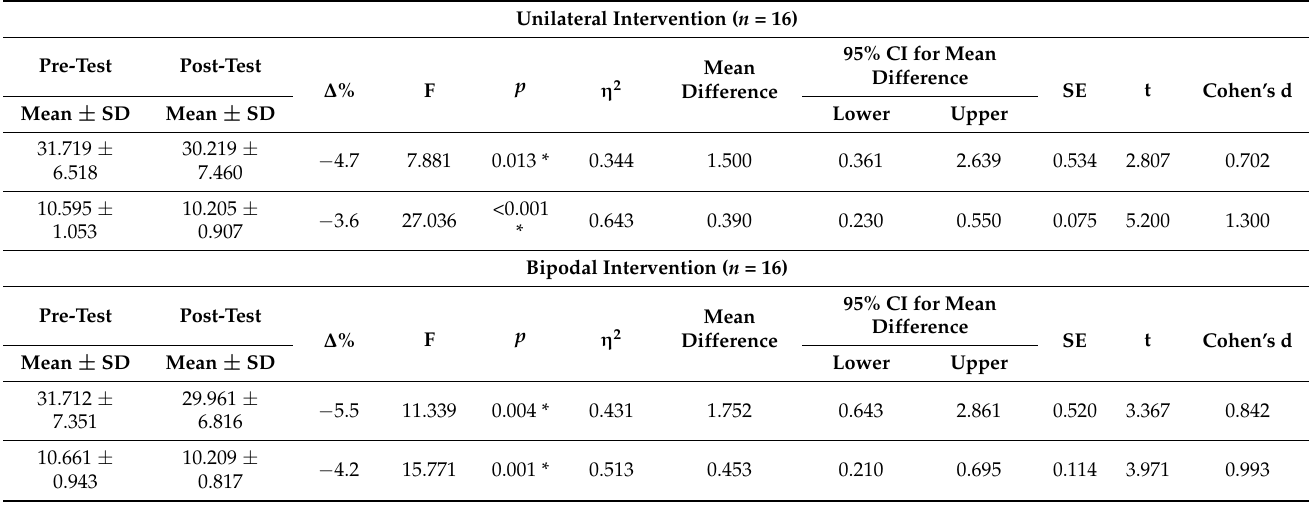
Table 1. Comparison between the pre-test and the post-test of the PAPE groups in the countermovement jump (CMJ) and in the T-agility